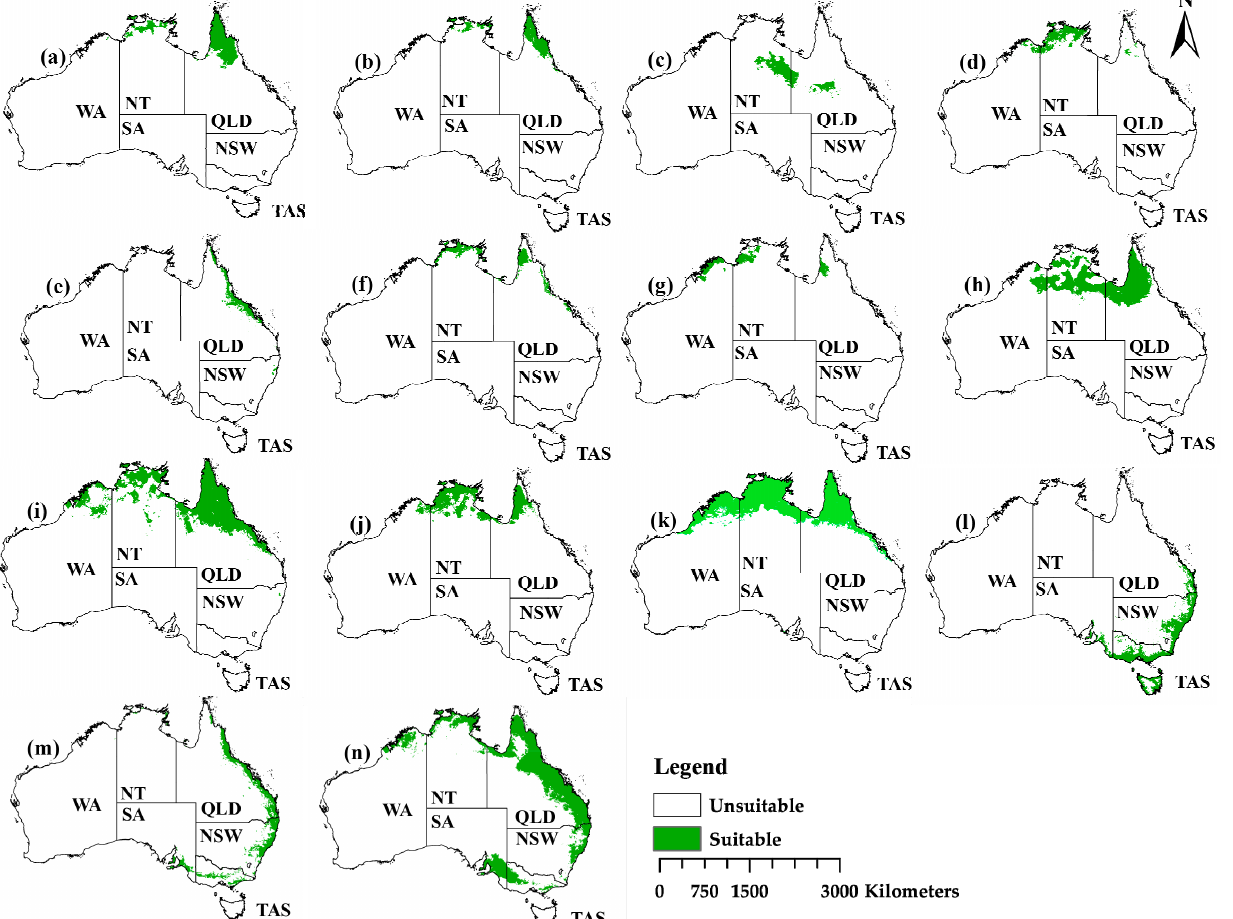
Figure 2. Estimates of the relative contributions of the environmental variables using MaxEnt models, fitted to the current, past and future projections for Nymphaea species in Australia. ( a ) N. atrans , ( b ) N. elleniae , ( c ) N. georginae , ( d ) N. hastifolia , ( e ) N. jacobsii , ( f ) N. pubescens , ( g ) N. ondinea , ( h ) N. carpentariae , ( i ) N. immutabilis , ( j ) N. macrosperma , ( k ) N. violancea , ( l ) N. alba , ( m ) N. nouchali , and ( n ) N. gigantea .